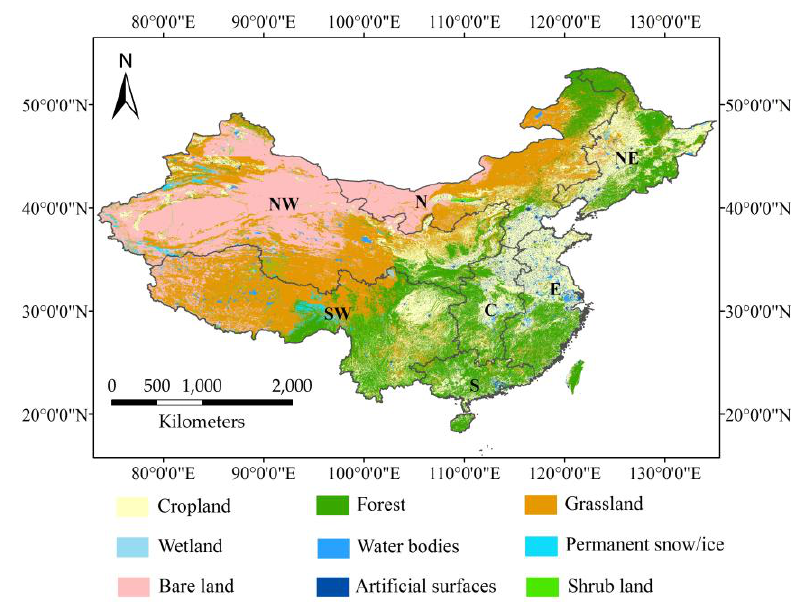
Figure 1. Map of the GlobeLand30-2010 land cover data in 33 provinces of China and the location of the seven geographical regions in this study.